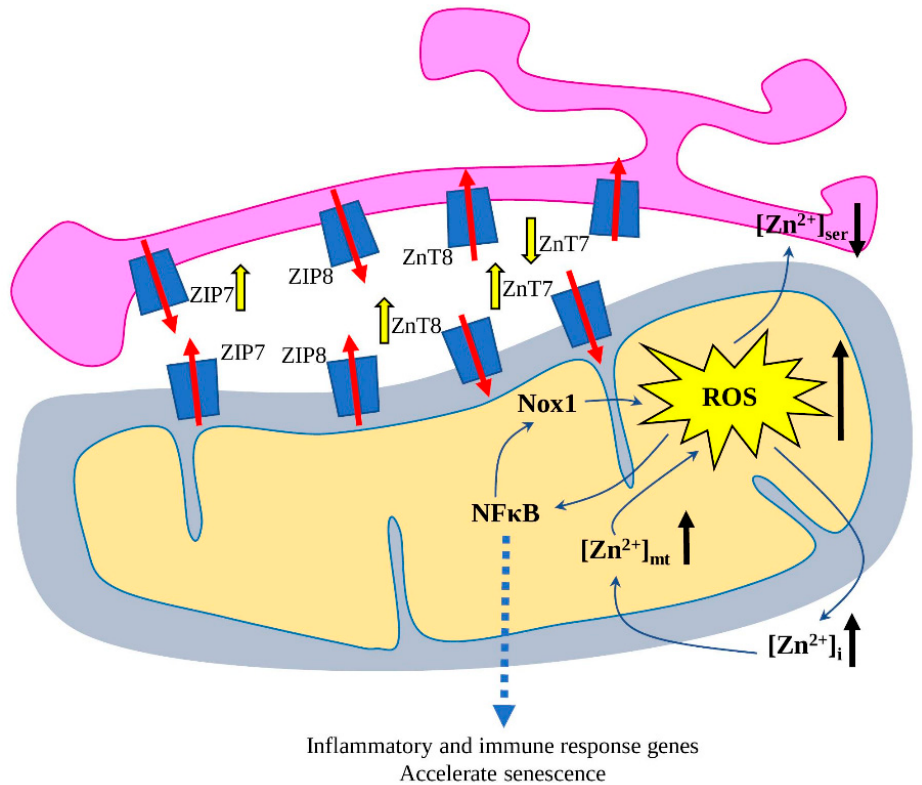
Figure 2. Redistribution of [Zn 2+ ] i , [Zn 2+ ] mt and [Zn 2+ ] ser in the aged cardiomyocytes during the development of ageing-mediated cardiac dysfunction. The increased ROS production is one of the leading factors, leading to the redistribution of Zn 2+ between cytosol, mitochondria and sarco/endoplasmic reticulum (SER) via modulated expression of Zn 2+ transporters. ROS activates nuclear factor- κ B (NF κ B), which translocates to the nucleus and activates different genes related to immune and inflammatory response. Further, NF κ B increases NADPH Oxidase 1 ( Nox1 ) expression, thus, further increasing ROS production and resulting in accelerated senescence. The ROS-mediated effects on the Zn 2+ transporters are depicted with yellow arrows; the direction of Zn 2+ transport—with red arrows, increased/decreased level of ROS and Zn 2+ —with black arrows.